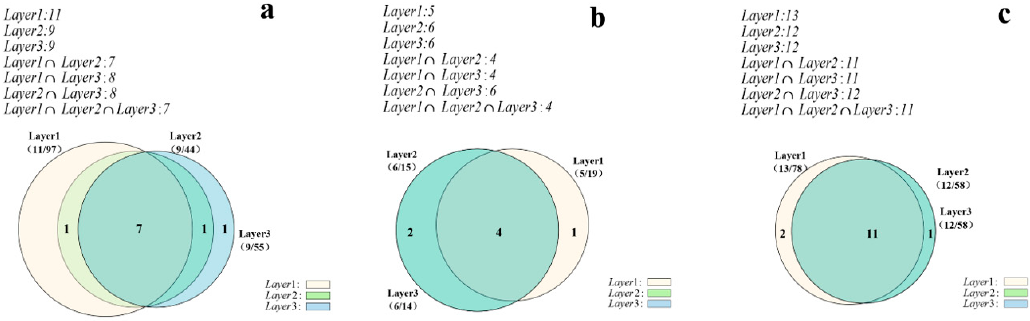
Figure 17. Distribution of overlapping nodes in selected areas: ( a ) area1, ( b ) area2, and ( c ) area3.